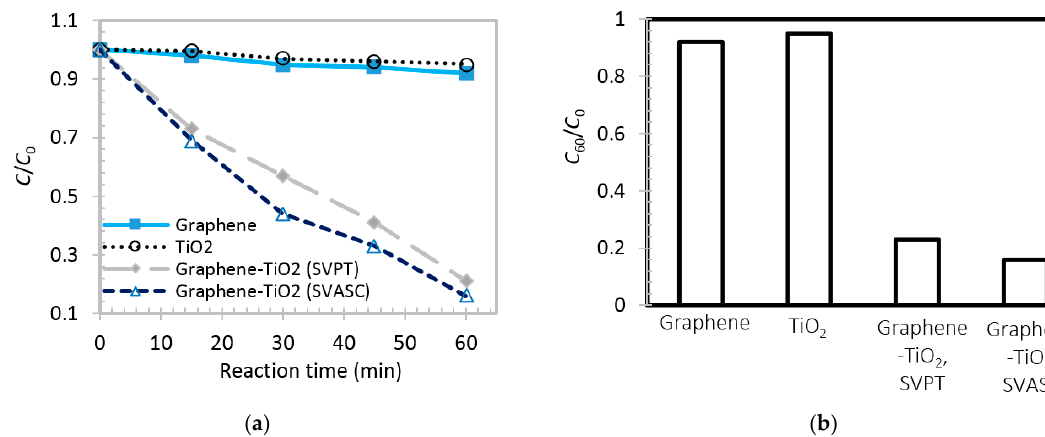
Figure 10. ( a ) Time varying photocatalytic performance of graphene, TiO 2 and graphene-TiO 2 thin films fabricated by spin-SVPT and SVASC; ( b ) Maximum photodegradation performance of the same films as those in ( a ) after 60 min under broadband illumination. The model reaction medium is methylene blue (MB) in deionized water. C 0 is the initial concentration of MB in water, and C 60 is the concentration after 60 min. All samples were annealed at 150 ◦ C and the graphene-TiO 2 samples were deposited from the precursor solution with a TS:GD volume ratio of 1:4.